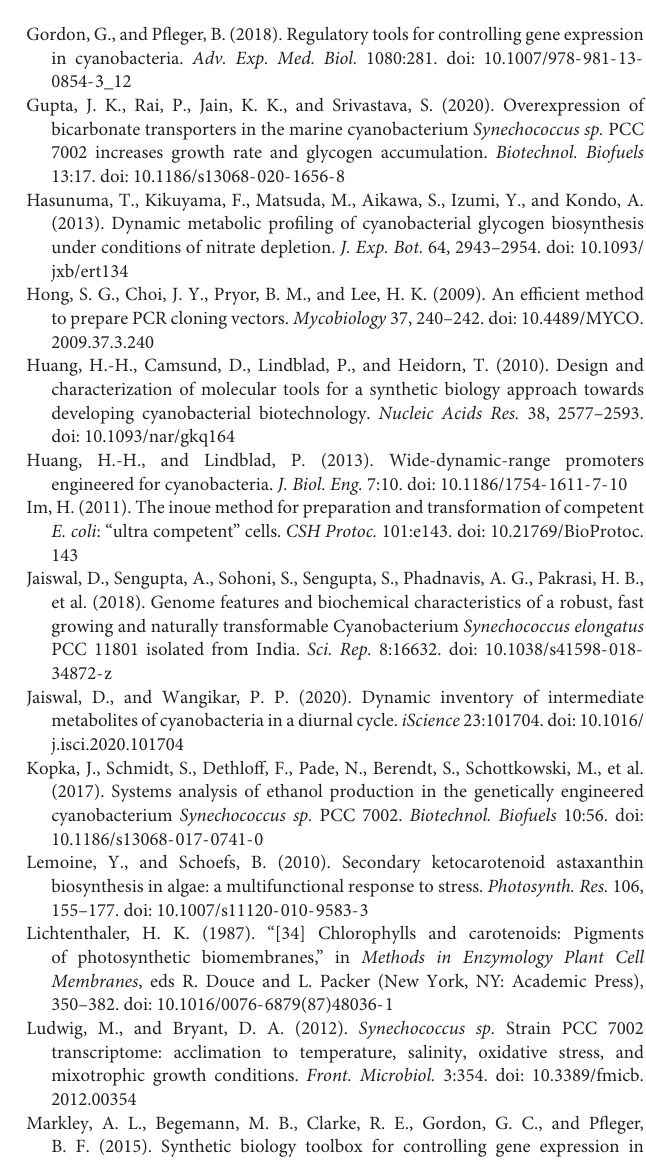
Supplementary Table 1 | The raw data used to construct various